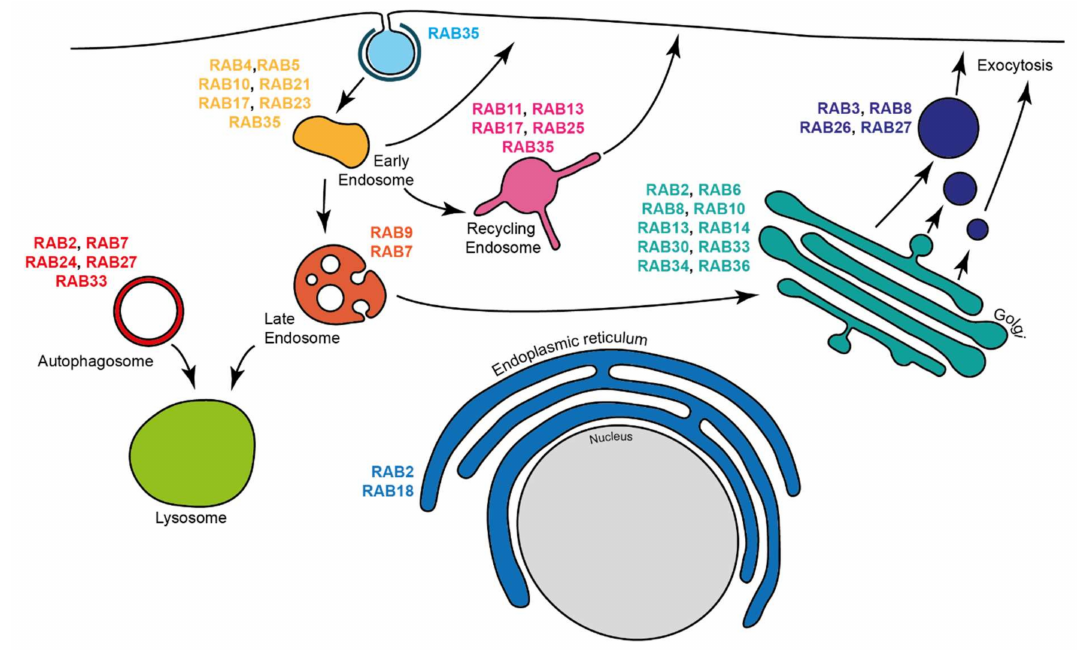
Figure 1. Rabs subcellular localization. Scheme illustrating the major cellular localizations of various